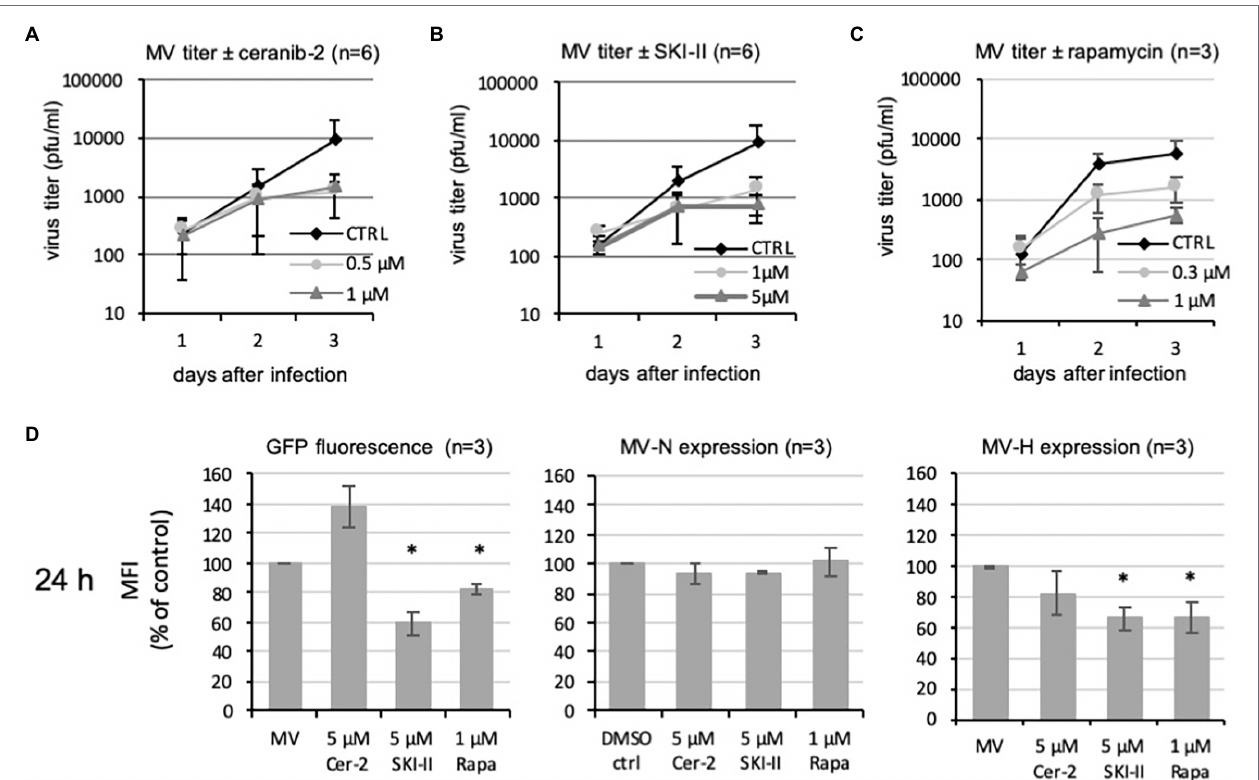
FIGURE 3 | Effects of ceranib-2 and SKI-II on MV replication and viral protein expression in PBL. Primary human PBL were treated with 0.2% DMSO as mock control (CTRL) or 0.5 and 1 μ m ceranib-2 (A) , 1 and 5 μ m SKI-II (B) , and 0.3 and 1 μ m rapamycin (C) simultaneously to infection with MV (MOI = 0.1). Newly synthesized infectious virus (cell bound plus supernatant) was titrated using Vero-hSLAM cells 1, 2, and 3 days after infection and mean viral titers are shown ( n = 6 for ceranib-2 and SKI-II and n = 3 for rapamycin). Reductions of viral titers were significant at days 2 and 3 (for clarity not shown in the graphic). In (D) , 24 h infected and inhibitor treated cells were analyzed by flow cytometry and the mean fluorescence intensities (MFI) of GFP, MV-nucleocapsid (MV-N), and MV-hemagglutinin (MV-H) in the cultures were quantified and presented as percent of control. Significant differences in comparison with the control were indicated with ( n = 3; with * p ≤ 0.05 calculated by student’s t